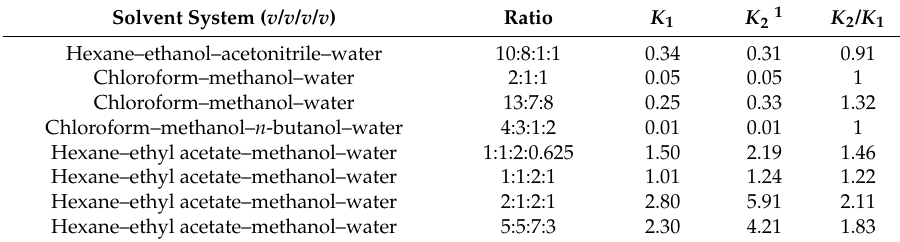
Table 2. Partition coefficient ( K value) of bergamottin in different solvent systems.